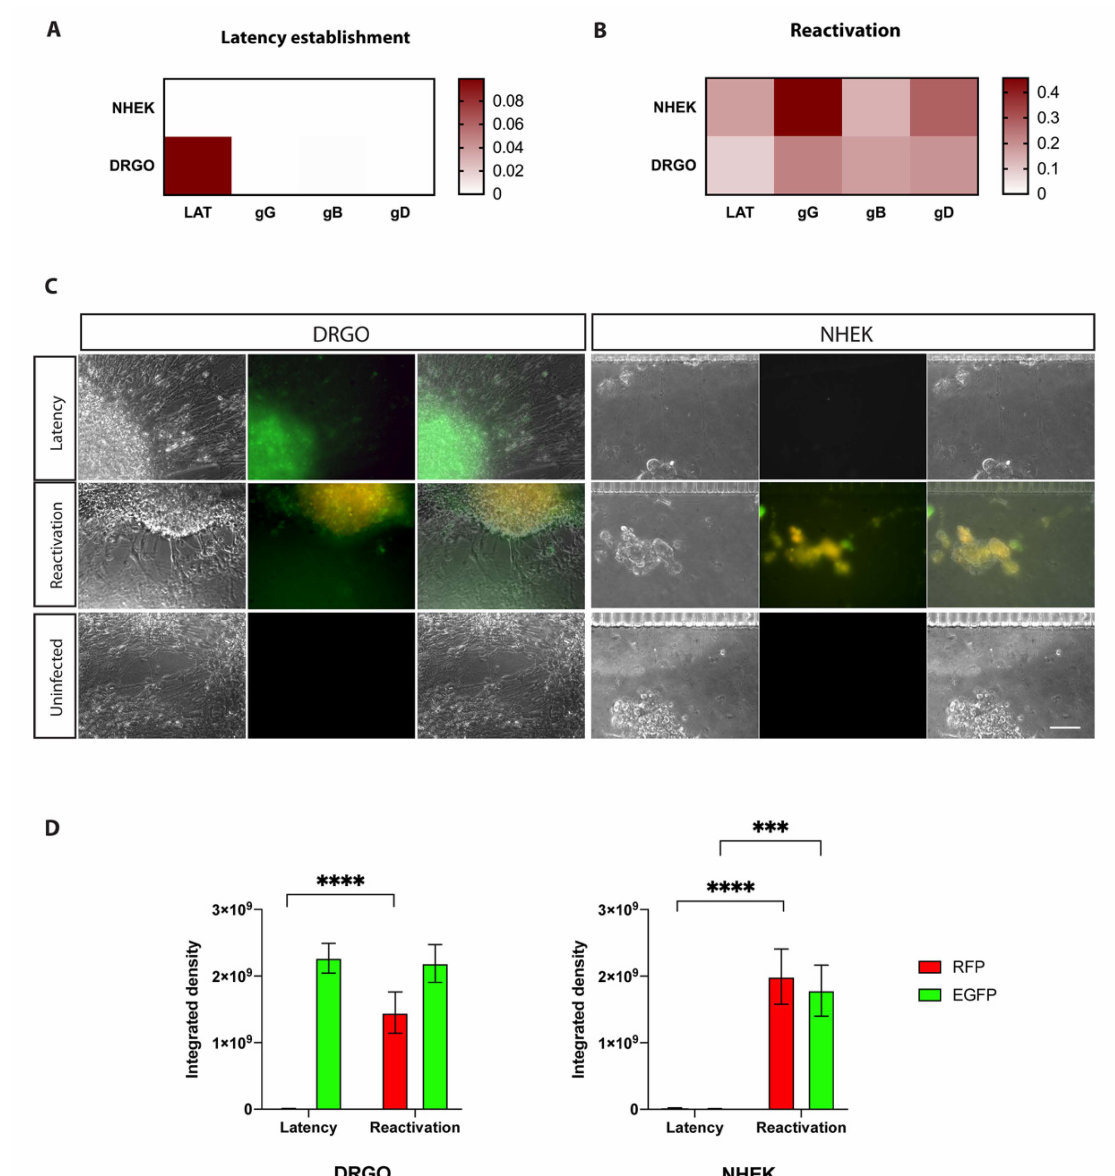
Figure 7. Retrograde–anterograde virus spread experiment (EXP #2). Virus gene expression profiling for HSV-1 latency establishment ( A ) indirectly in DRGOs. NHEK cells were infected, and retrograde transport of virus particles resulted in HSV-1 latency establishment in organoids. Thermal stress led to controlled reactivation ( B ), and anterograde transport of virus particles resulted in NHEK lytic infection. ( C ) Live imaging of DRGOs and NHEKs showing recombinant HSV-1 during latency (pICP0 active, green) and reactivation (pICP0 and pgC active, yellow). Scale bar, 100 µ m. ( D ) Levels of ICP0 (green fluorescent signal) and gC (red fluorescent signal) expression measured as integrated density values for DRGOs and NHEKs, during latency and reactivation. Mean ± SD, *** p < 0.001, **** p < 0.0001, n = 6 independent experiments (12